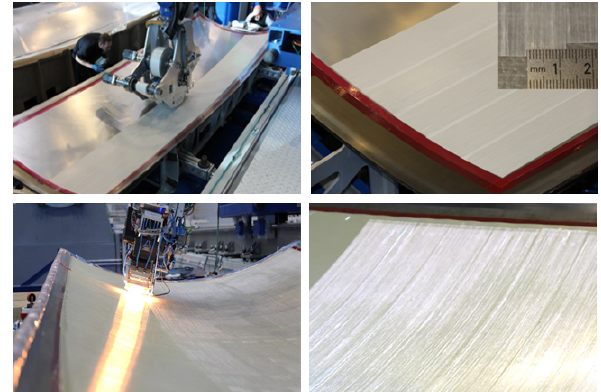
Figure 3: Manufacturing of double curved fuselage skin demonstra- tors with placement technologies ATL (top) and AFP (bottom) in DLRs research platform Grofi (cid:114) , Stade, © DLR cessibility and layup behavior along a curved path (steer-